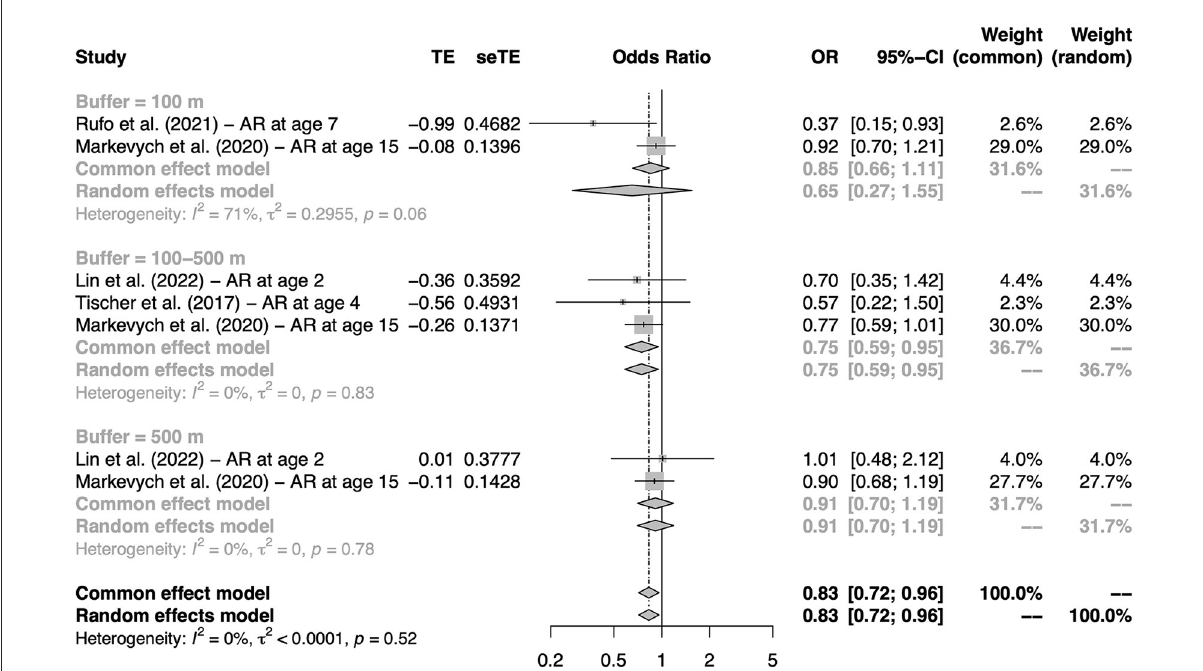
FIGURE4 The association between residential greenness at birth and AR in childhood. Subgroups were defined according to the buffers of the exposure measure.